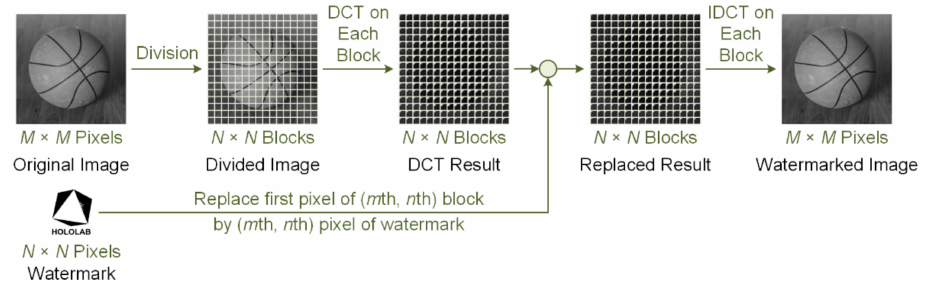
Figure 2. The DCT-based insertion of the